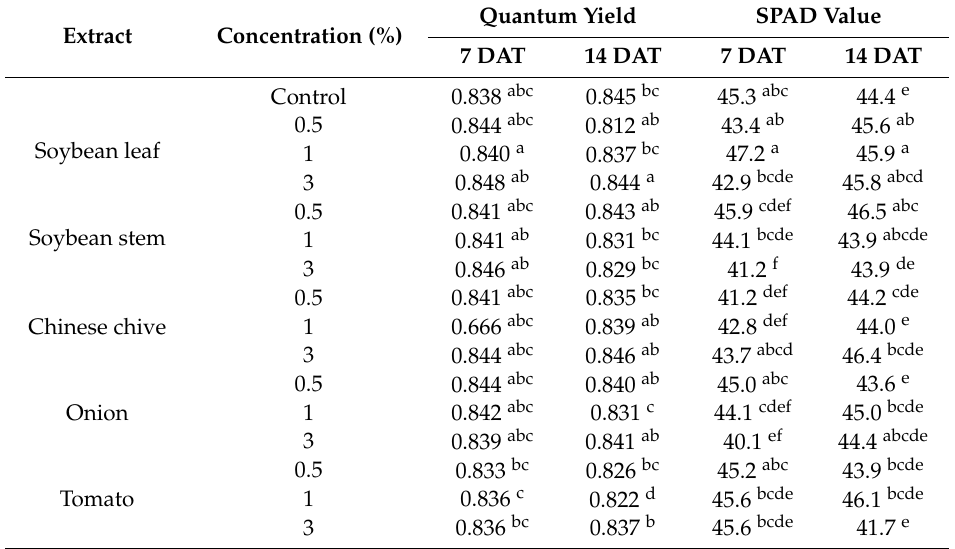
Table 1. Quantum yield (photosynthesis e ffi cacy) and SPAD (Soil Plant Analysis Development) values (chlorophyll content) in Peucedanum japonicum at 7 and 14 days after treatment (DAT) of various plant